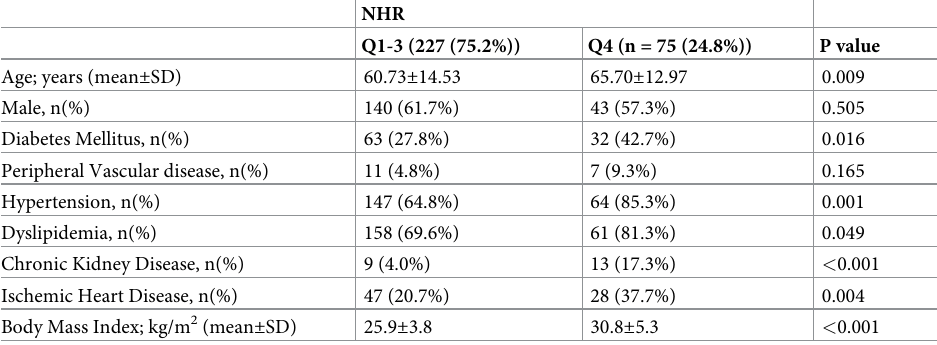
Table 2. Frequencies of co-morbidities for patients in the lower three quartiles to upper quartile of NFV/height ratio.